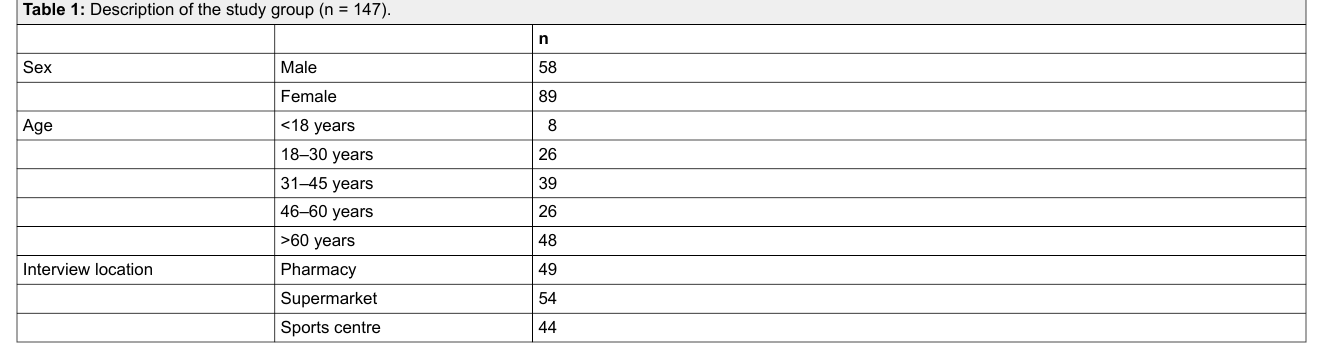
Table 1: Description of the study group (n =